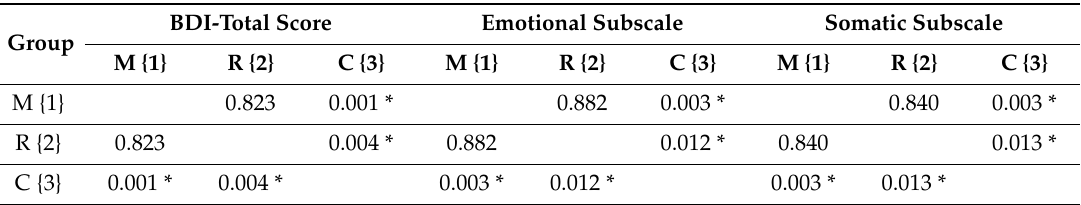
Table 4. Sche ff e’s post-hoc test for the BDI variables between the massage (M), relaxation (R) and control (C) groups.